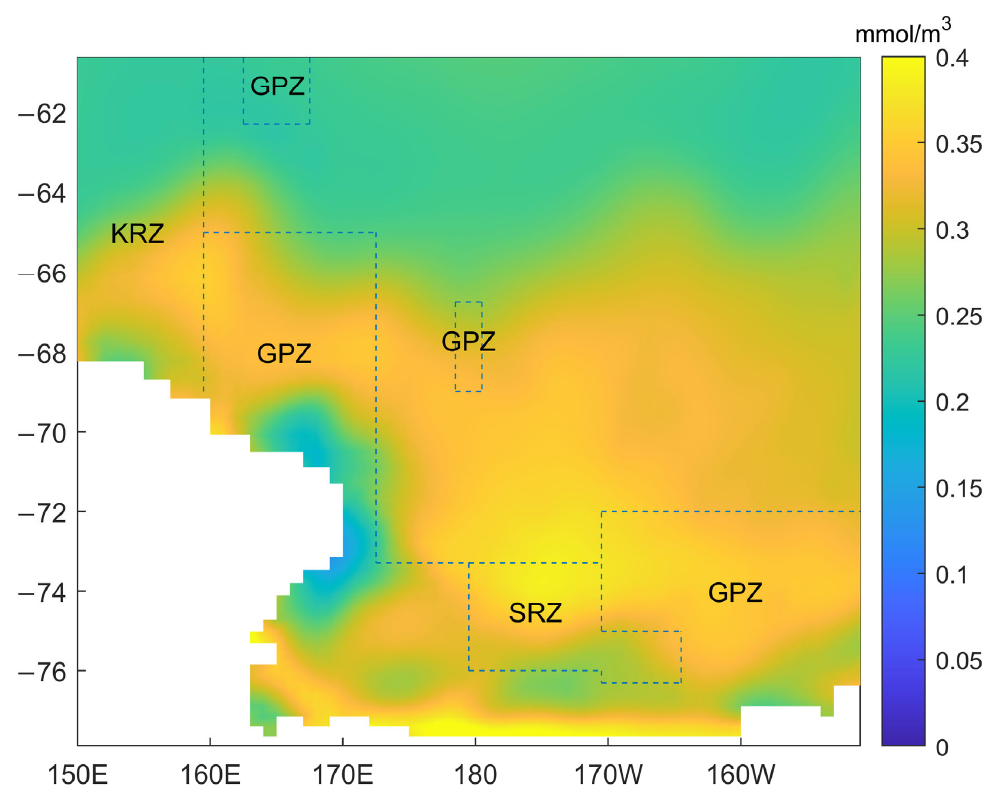
Figure 5. Average biomass in the Ross Sea area in February from 1958 to 2018 and location of the marine protected areas (dotted line).